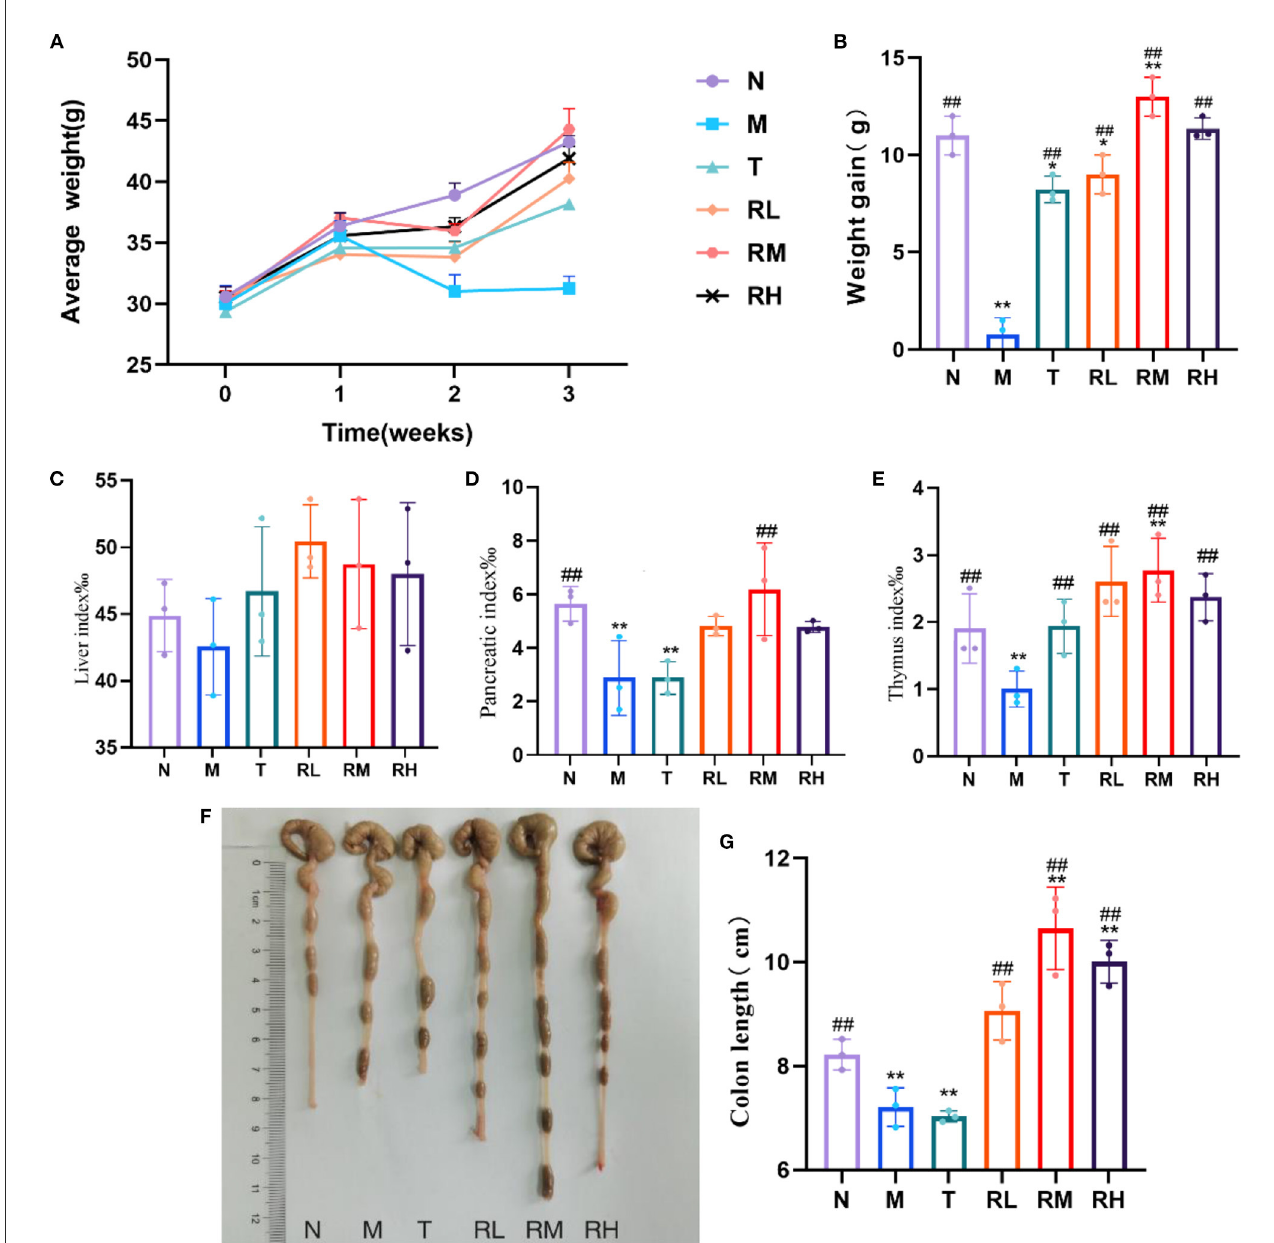
FIGURE2 Changes of body weight, immune organ index and colon length in mice during the test. (A) Weekly body weight of mice. (B) Body weight gain of mice. (C) Liver index. (D) Pancreatic index. (E) Thymus index. (F) Colon of mice. (G) Length of colon. Compared with group N: * P < 0.05, ** P < 0.01; compared with group M. # P < 0.05, ## P <